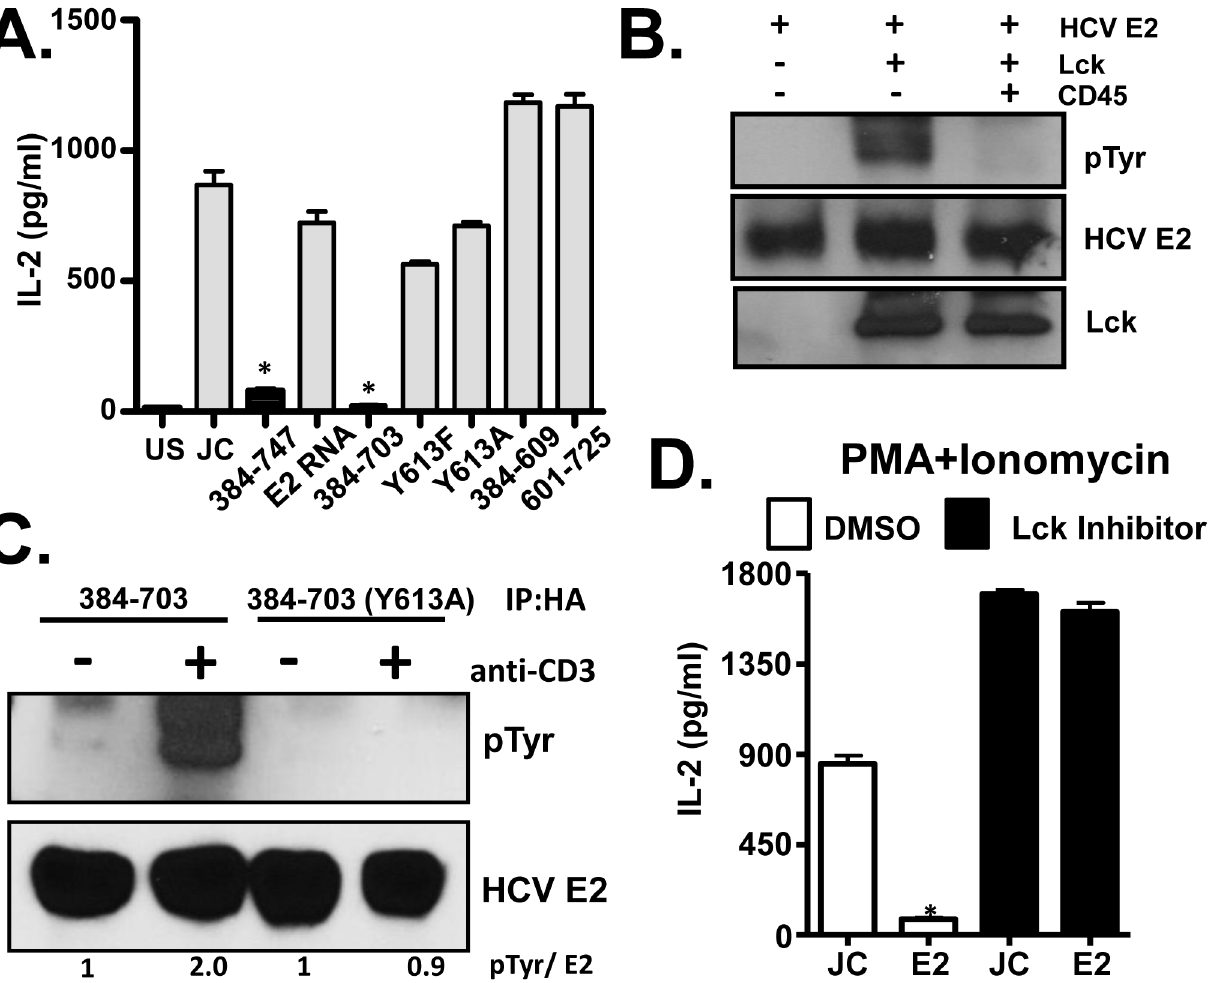
Fig 7. HCV E2 protein inhibits distal T cell receptor (TCR) signaling. PMA + Ionomycin (P+I) mediated IL-2 release by Jurkat cells expressing full-length or various truncated or tyrosine 613 mutant HCV E2 protein fragments as indicated (A). Recombinant HCV E2 protein was phosphorylated by Lck in an in vitro kinase reaction, and was dephosphorylated by the CD45 phosphatase (B). HCV E2 protein (native, or Y613A mutant) expressed in Jurkat cells was precipitated before (-) or after (+) TCR stimulation with anti-CD3. E2 and phospho-E2 were detected by immunoblot with E2 specific antibody or anti- phosphotyrosine antibody respectively (C). P+I mediated IL-2 release control Jurkat cells (JC) or HCV E2-expressing Jurkat cells (384 – 747) which had been incubated in 100 μ g/ml Lck inhibitor or the vehicle control (DMSO) (D). Data represent the average of three technical replicates and the standard deviation is shown. Each experiment was repeated at least three times with consistent results. * P <